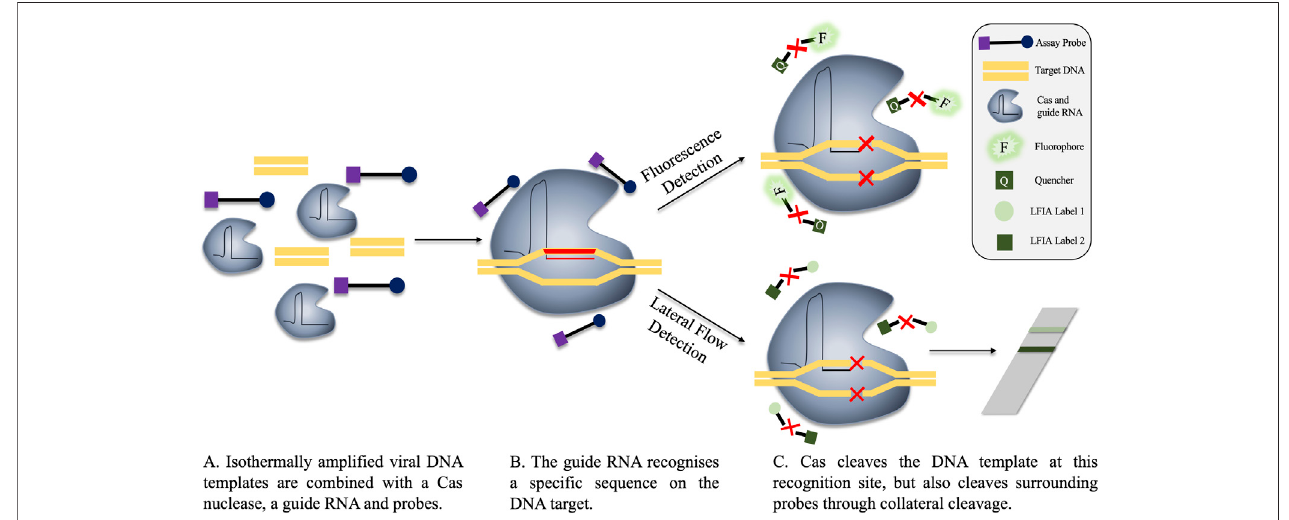
FIGURE5| Fluorescence and lateral fl ow-baseddetection ina CRISPR-Cas detection system. (A) The componentsofthereactionare combined, either beforeor after isothermal ampli fi cation. The guide RNA is speci fi c for a region on the target viral DNA. (B) The guide RNA recognises the target sequence, locating the Cas nucleaseto thisregion. (C) The DNA target is cleaved by the Cas nuclease mechanism. However, Cas also performs collateral cleavage on surrounding single-stranded probes.Cleavageisrepresentedinthediagrambyared X.Theseprobescanbe fl uorescent ( C ,top),where thecleavageoftheprobeseparatesthequencherand the fl uorophore,permitting fl uorescentsignal.Alternatively,probescanbeusedinlateral fl owassays,wherebycleavageoftheprobeproducestwodistinctbandsonthe fl ow-strip, indicating a positive result. A single band on the lateral fl ow strip is representative of a negative result as no cleavage events occurred and the labels are not separated ( C ,